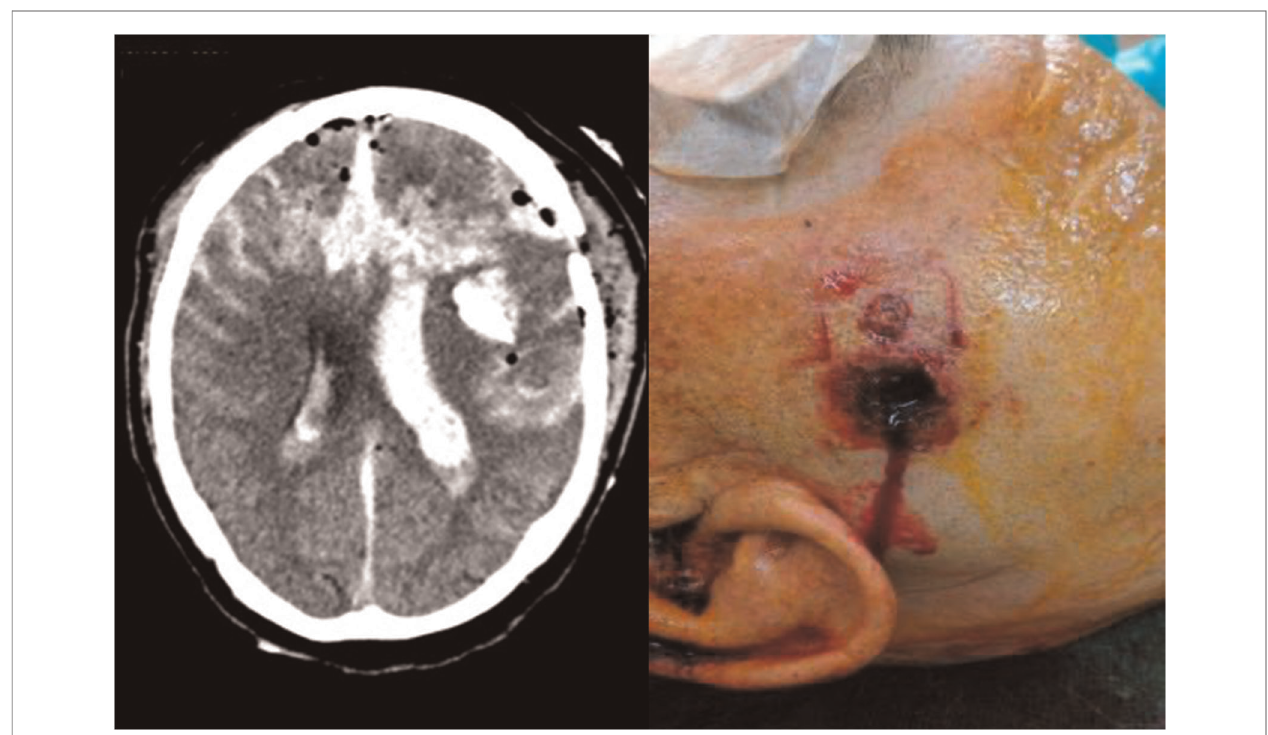
FIGURE 2 | High-velocity injury (HVI); self-in fl icted gunshot wound; (left) bilateral trajectory on CCT, (right) muzzle